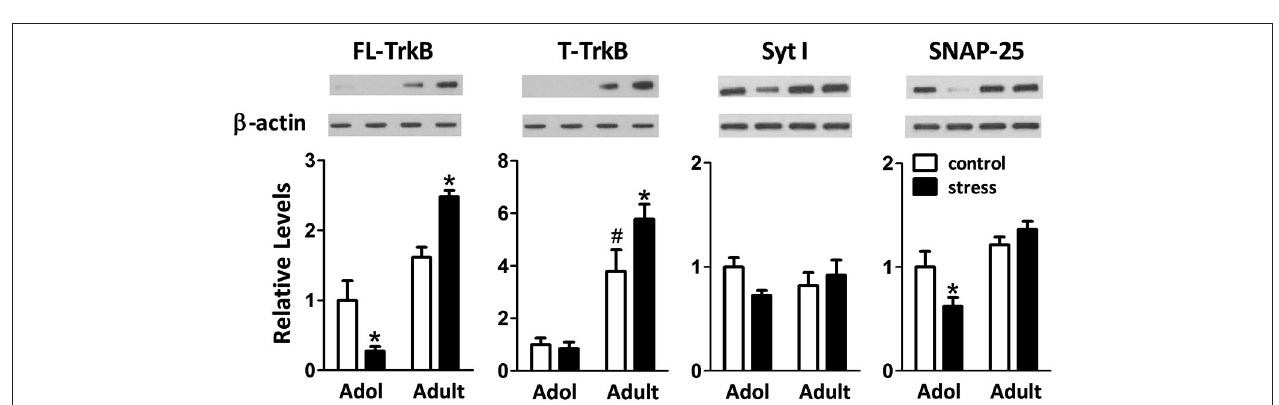
FIGURE 4 | Effects of stress on the spine density of BLA neurons in adolescent and adult rats. (A) Representative two-photon laser scanning micrographs revealed spines located at different orders of dendrites of the BLA neurons in adolescent and adult rats with (stress) or without (control)